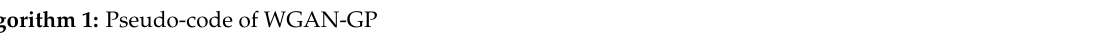
Algorithm 1: Pseudo-code of